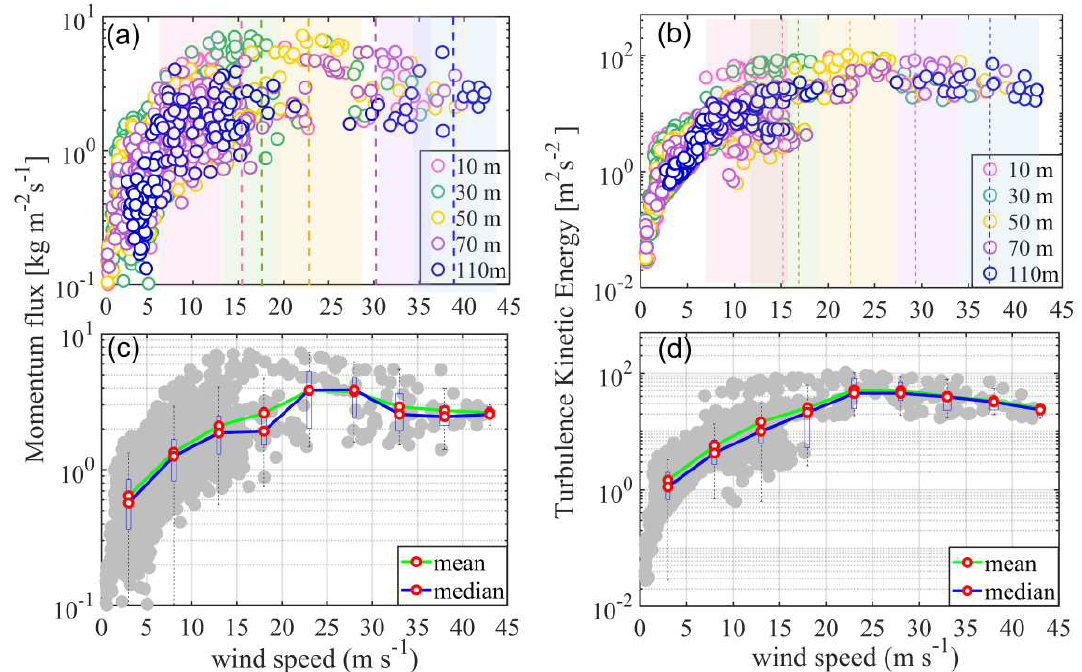
Figure 9. Plots of the ( a ) momentum flux and ( b ) turbulent kinetic energy at the five height levels during Typhoon Maria. Plots of the ( c ) momentum fluxes and ( d ) turbulent kinetic energy as a function of wind speeds at the five heights during landfall of Typhoon Maria. The blue line with the red circles is the bin median average at 5 m s −1 intervals of u n from the observations. The yellow line with red circle is the bin mean average at 5 m s −1 intervals of u n from the observations.